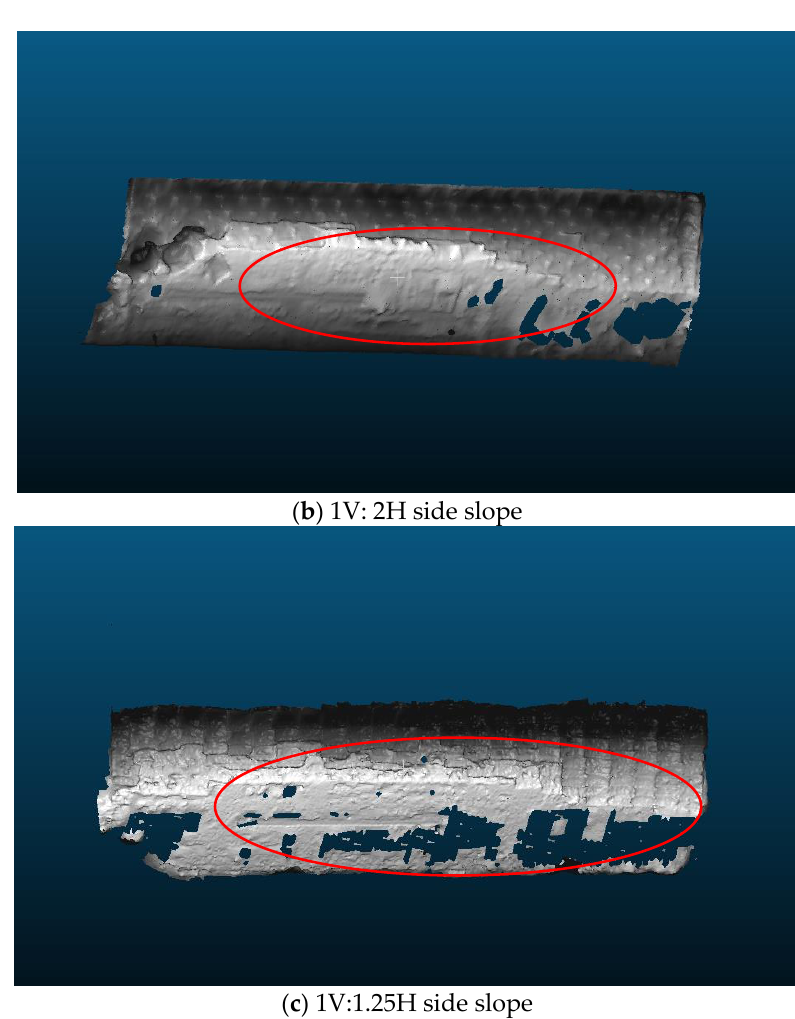
Figure 10. Failure zones for different side slopes. Note that the “holes” shown in the meshes are due to the lack of sufficient image overlap.